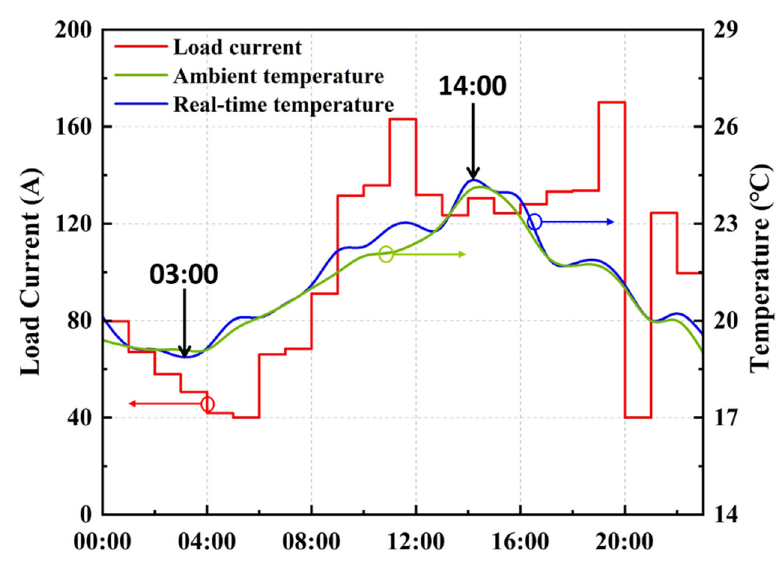
Figure 9. The experimental results of the cable temperature